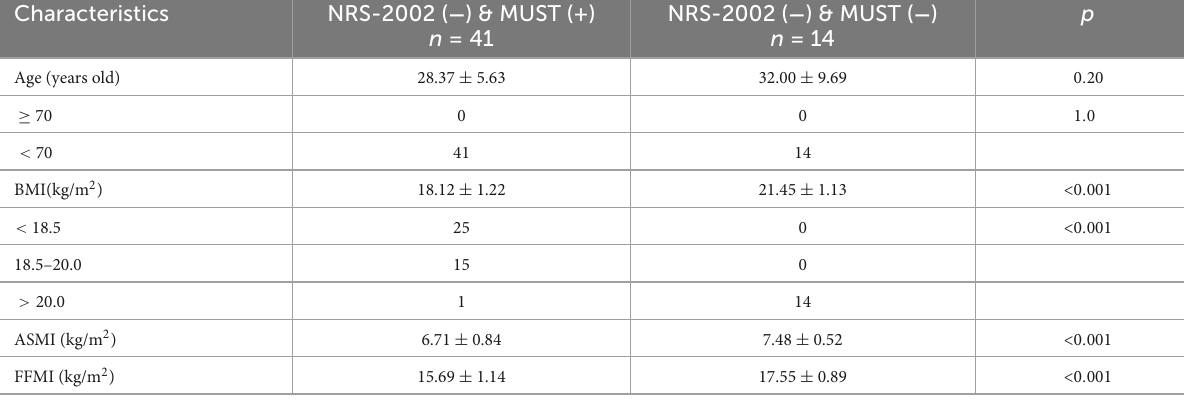
TABLE 4 Comparisons of basic characteristics between the patients with NRS-2002 ( − ) & MUST (+) and the patients with NRS-2002 ( − ) & MUST ( − ) ( n = 55).